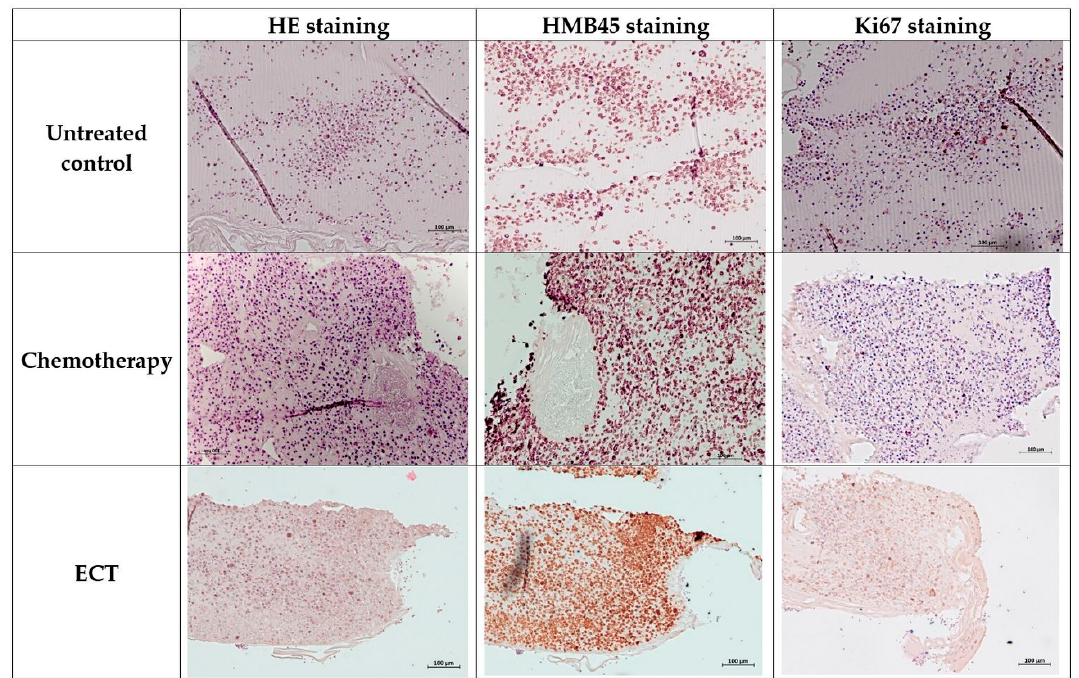
Figure 7. Representative IHC stains of human 92.1 UM cells in the CAM at E16 following ECT (2.5 µg/mL bleomycin and eight pulses 750 V/cm pulse strength) compared to chemotherapy alone and untreated controls. PAS staining of central CAM section with necrotic areas) and reduction of growth after ECT (negative for hematoxylin). Immunohistochemically stained with antihuman melanosome marker HMB45, large areas of necrosis after chemotherapy and after ECT with significant reduction of growth after ECT. Ki67 labeling of central CAM section, peripheral proliferating cells, central Ki67 negative cells after ECT. Scale bars = 100 µm.